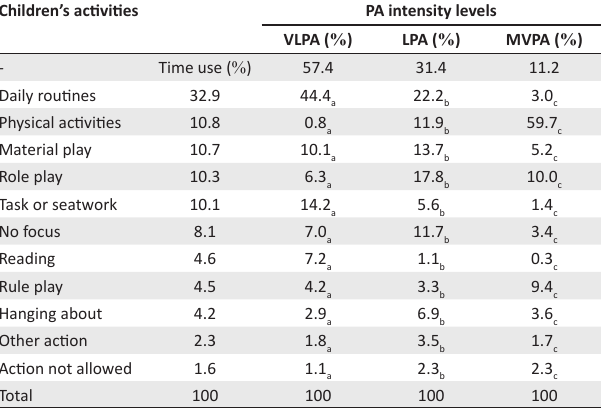
TABLE 1: Children’s time use and proportions of the physical activity intensity levels (of all observations in each intensity level) in children’s activities ( N = 57